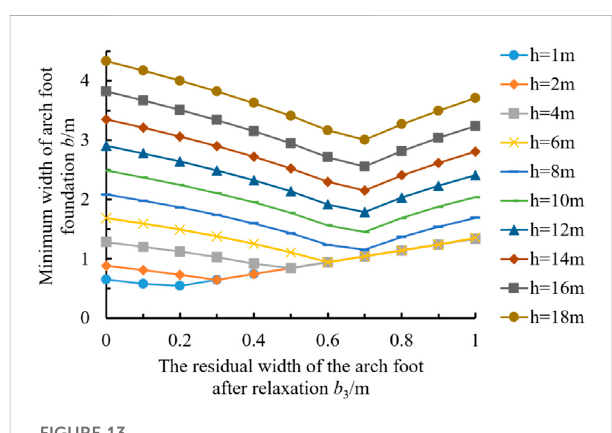
FIGURE 13 Relationship between thickness and width with different tunnel